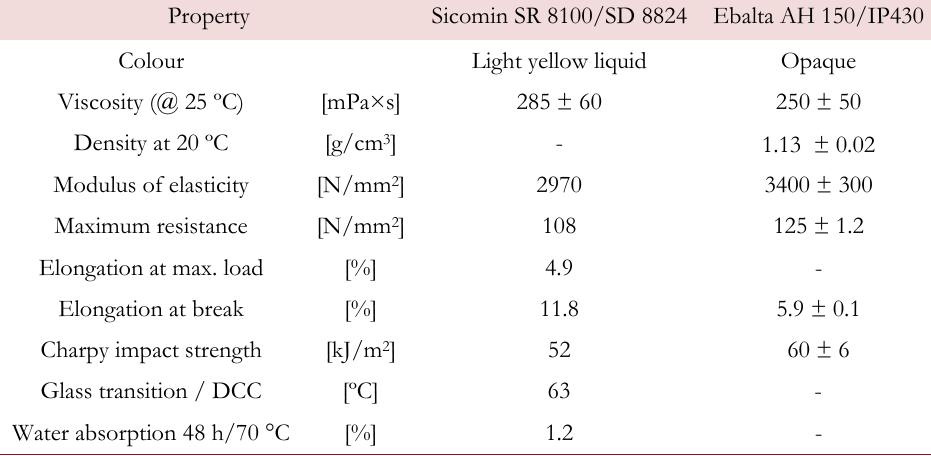
Table 1: Main mechanical and physical properties of the epoxy resins.